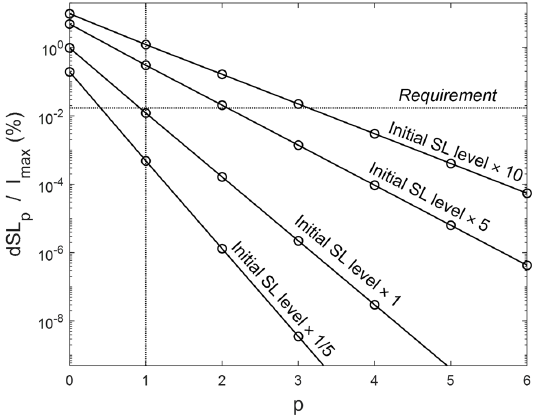
Figure 3. Residual SL as a function of the iteration, for different initial SL levels in 3MI.